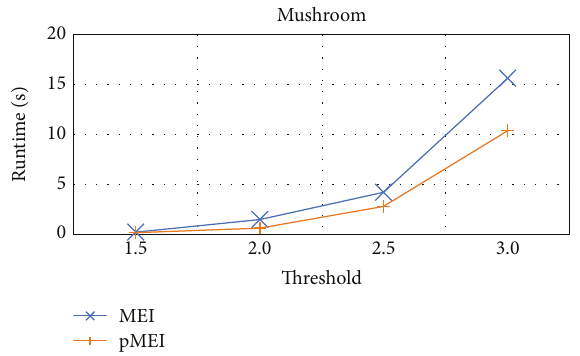
Figure 5: Runtimes of the MEI and pMEI methods on the Mushroom.